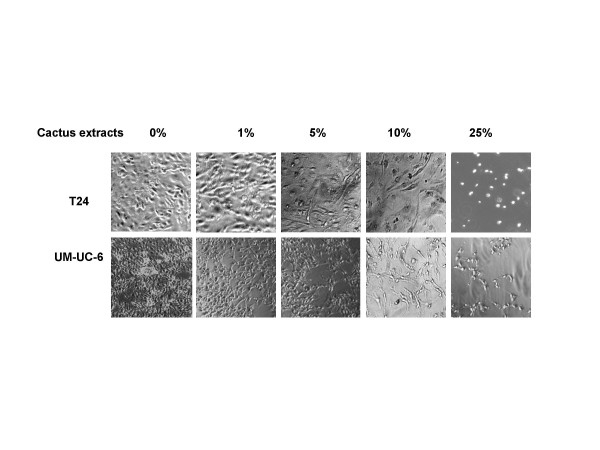
Effect of cactus pear extracts on the morphology of bladder cancer cells. Bladder cancer cells were grown in the absence (control) or presence of different concentrations of cactus extracts. The photographs were taken on day 3 after the removal of medium containing floating cells.